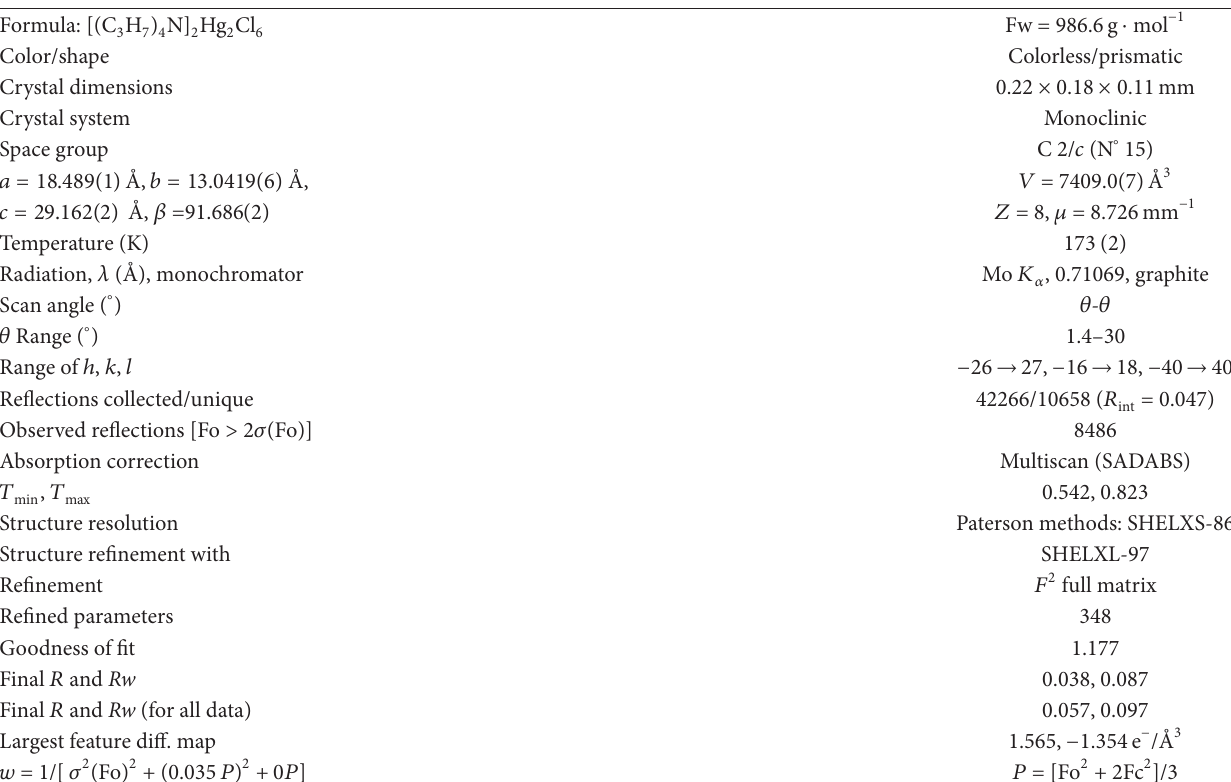
H ) ] Hg Cl 3 7 4 2 2 6